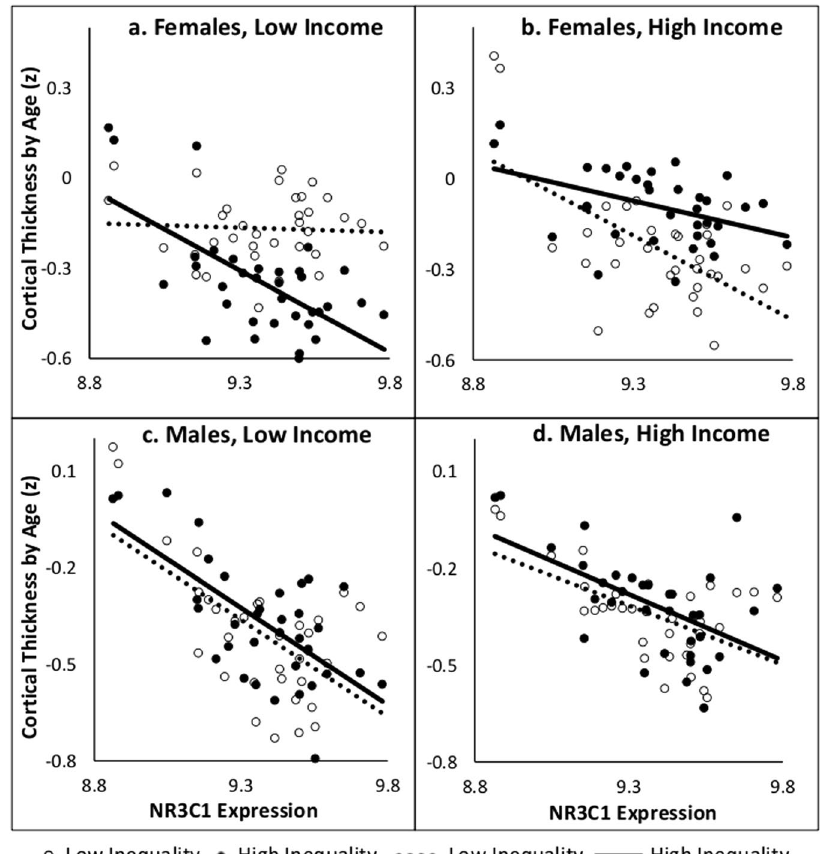
Figure 2. The y-axis (Cortical Thickness by Age) is the Fisher z-transformed correlation coefficients of cortical thickness and age in each of the 34 regions. The x-axis is the NR3C1 expression in each of these regions. For each subgroup, there are 34 points representing each cortical region. Each male and female income subgroups are divided into high (solid circle, solid line) and low (hollow circle, dashed line) inequality subgroups. An inequality by NR3C1 expression interaction was analyzed for each income